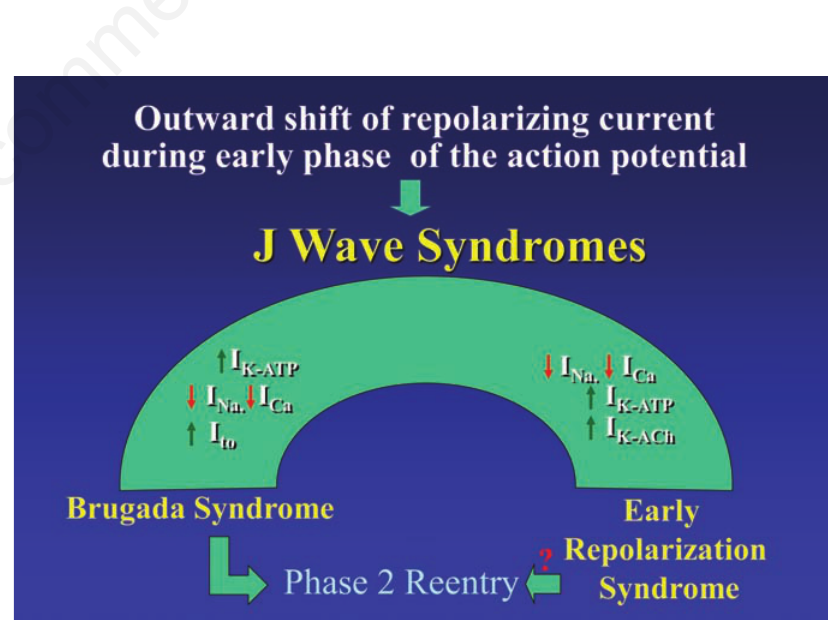
Figure 4. J wave syndromes. Schematic depicting our working hypothesis that an outward shift in repolarizing current due to a decrease in sodium or calcium channel currents or an increase in I , I or I , or other outward currents can give rise to accentuated J to K-ATP K-ACh waves associated with the Brugada syndrome and early repolarization syndrome (ERS). Both are thought to be triggered by closely-coupled phase 2 reentrant extrasystoles, but in the case of ERS a Purkinje source of ectopic activity is also suspected (modified from Antzelevitch and Yan, 2010 9 with permission)